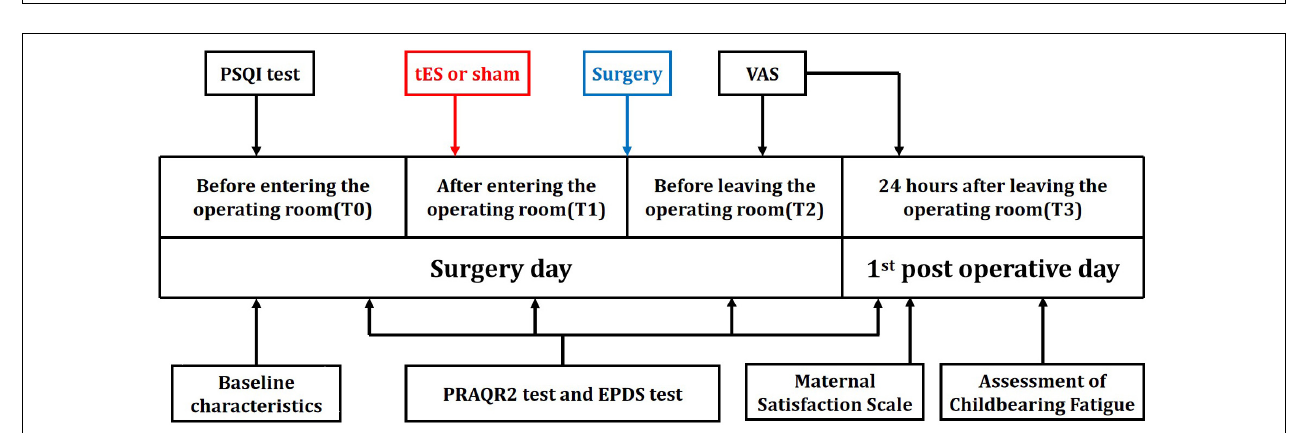
FIGURE 1 | CONSORT flow diagram.